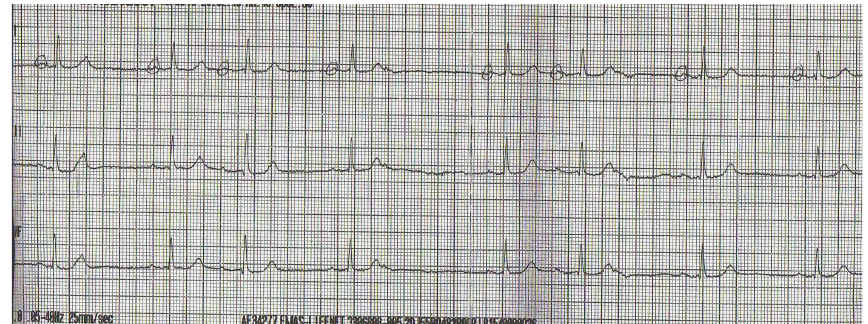
Figure 2: ECG with sinus dysfunction and Mobitz 1